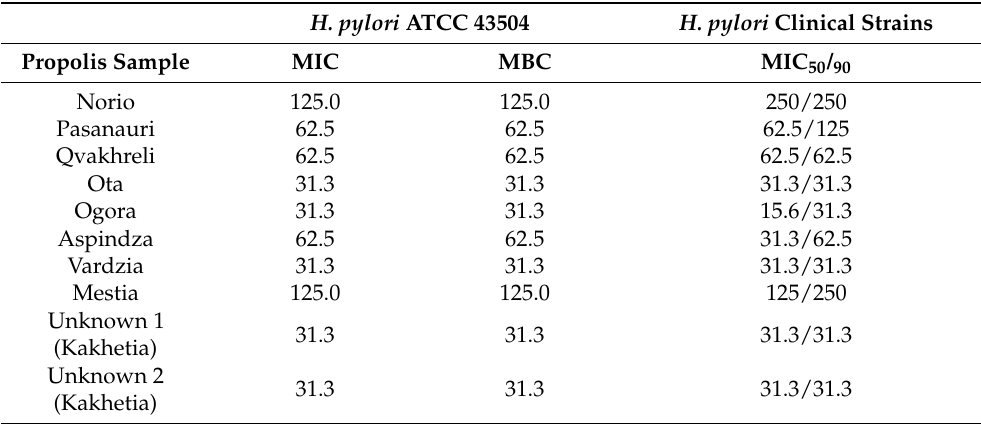
Table 1. Antimicrobial properties of Georgian propolis extracts against the reference H. pylori ATCC 43504 and clinical H. pylori